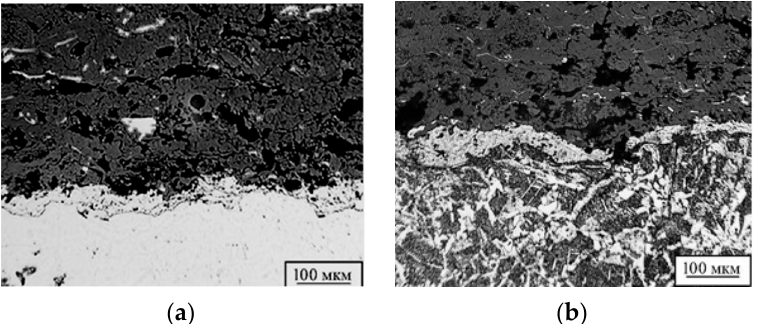
Figure 13. Study of the microstructure of recovered samples using advanced technology (micrographs obtained using an optical microscope): ( a )—sample without etching, ( b )—sample after etching.